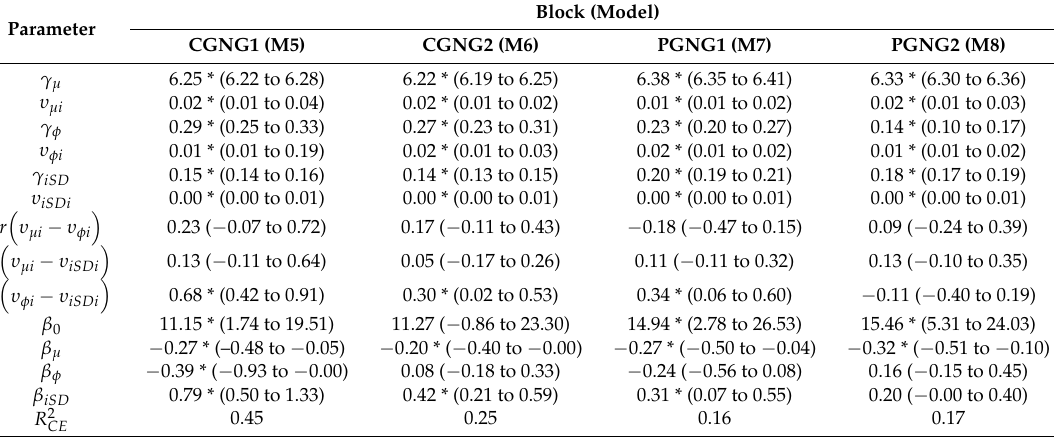
Table A1. Posterior means (and 95% credible intervals) of fixed effects, random effect variances, correlations between random effects, intercepts and regression weights of CE i on µ i , iSD i and φ i estimated for models 5 to 8. Mean fixed effects and random variances are shown in raw metrics while correlations and regression weights are shown in within-level standardized